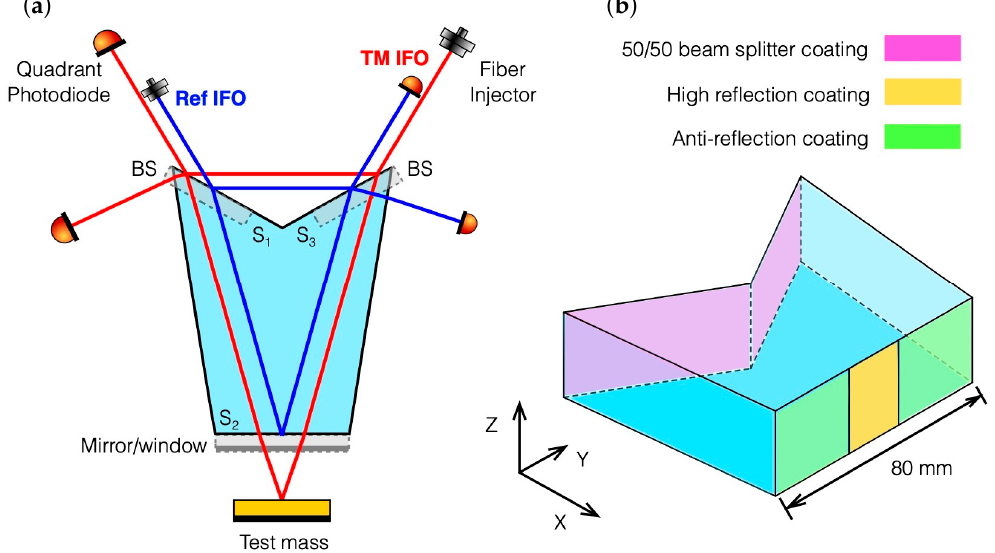
Figure 1. Single-element dual-interferometer optical head layout. A frequency-modulated laser beam is split and delivered via two optical fibers to the heptagonal prism ( a ). The prism has three main optical surfaces: S 1 and S 3 are used to split and recombine the laser beams, while S 2 acts as mirror for the reference interferometer (Ref IFO), and as a window for the test mass inertial sensing interferometer (TM IFO). The shape of the prism is optimized via simulation to provide insensitivity to manufacturing tolerances and rejection of stray light noise. Additionally drawn is a 3D view of the prism showing the required optical coatings ( b Table 1. Parameters of the whole setup. AOI is angle of incidence.